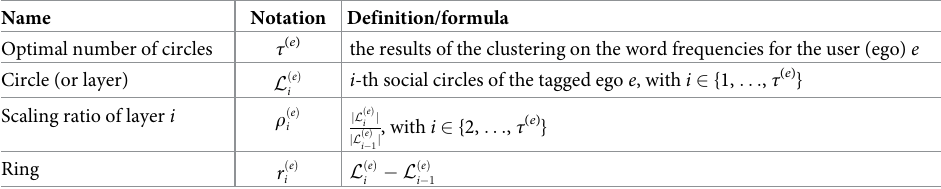
Table 2. Summary of notation used in the structural